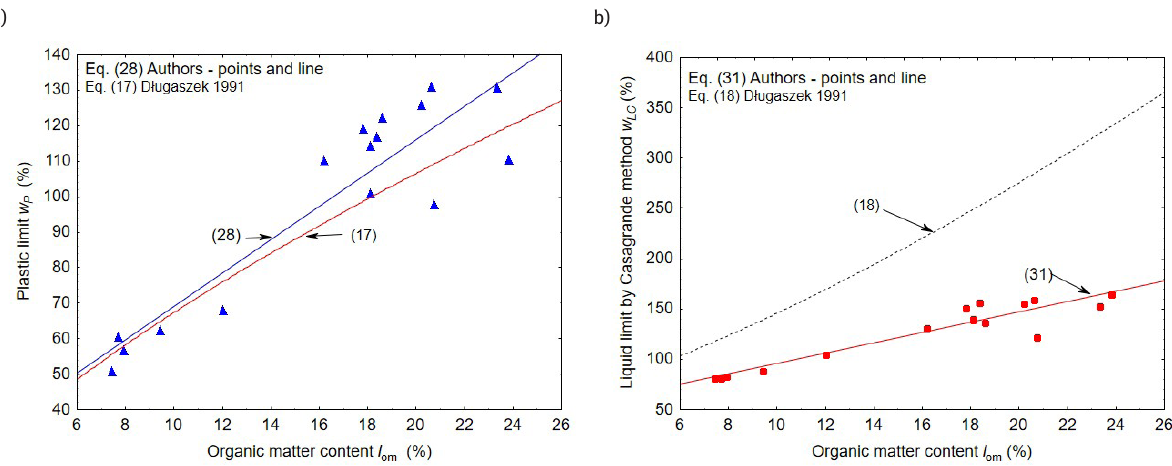
Figure 6: Comparison between the measured and calculated values: a) w (33) in Table 5 of Eemian gyttja, with zones of maximum RE for regression models. Note: RE, relative error.